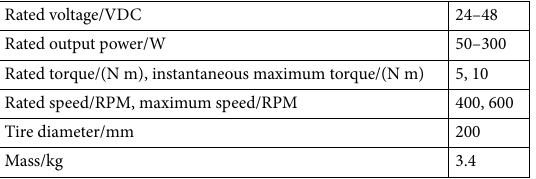
Table 1. Hub motor parameters.